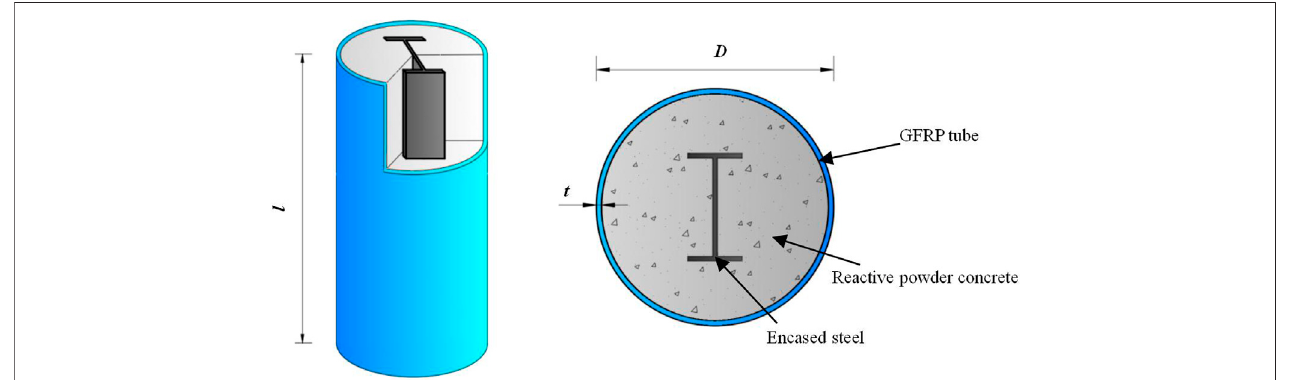
FIGURE 1 | Sketch of specimens: (A) the whole GRS columns; (B) cross-section of GRS columns.